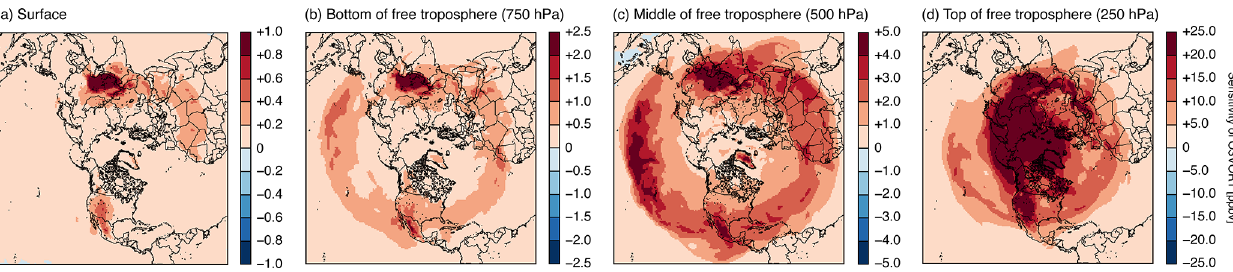
Figure 7. Monthly averaged sensitivity of O3VORT at (a) surface, (b) bottom of free troposphere (750hPa), (c) middle of free troposphere (500hPa), and (d) top of free troposphere